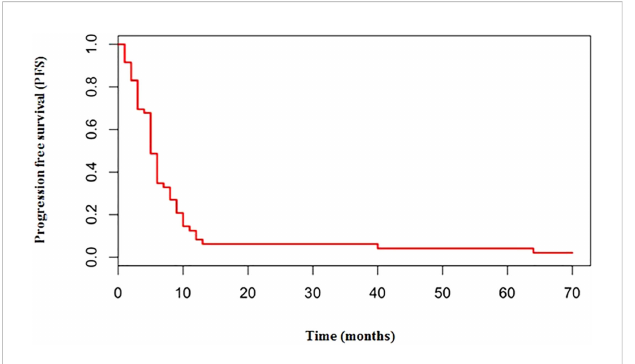
FIGURE 1 Median PFS in overall population treated with platinum/etoposide mPFS: 5 months.